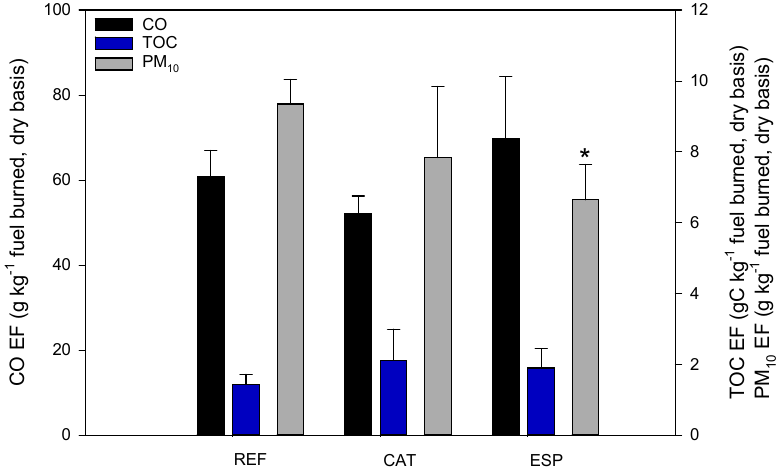
Figure 2. CO, TOC and PM 10 emission factors from pine wood combustion with or without catalytic converter (CAT) and electrostatic precipitator (ESP). Asterisks indicate statistically significant difference compared to the reference condition (REF) ( p < 0.05; Kruskal–Wallis test).